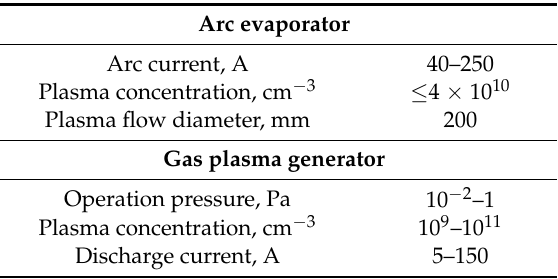
Table 1. Experimental setup